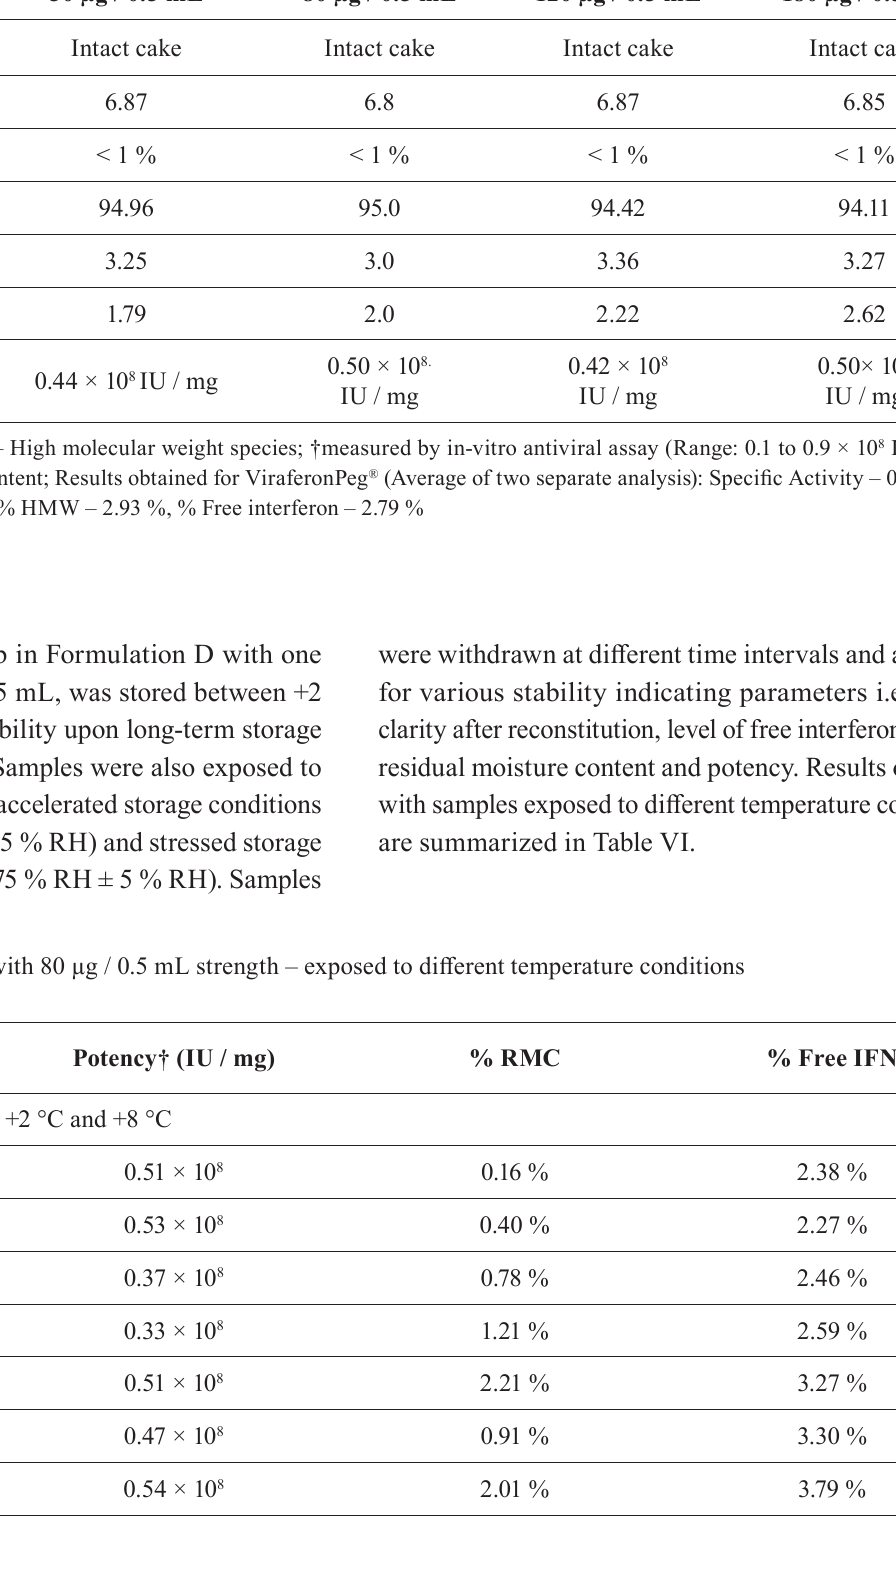
TABLE V - P hysico-chemical and biological test results: Formulation D with different strengths Parameters 50 µg / 0.5 mL 80 µg / 0.5 mL 120 µg / 0.5 mL 180 µg / 0.5 mL Appearance Intact cake Intact cake Intact cake